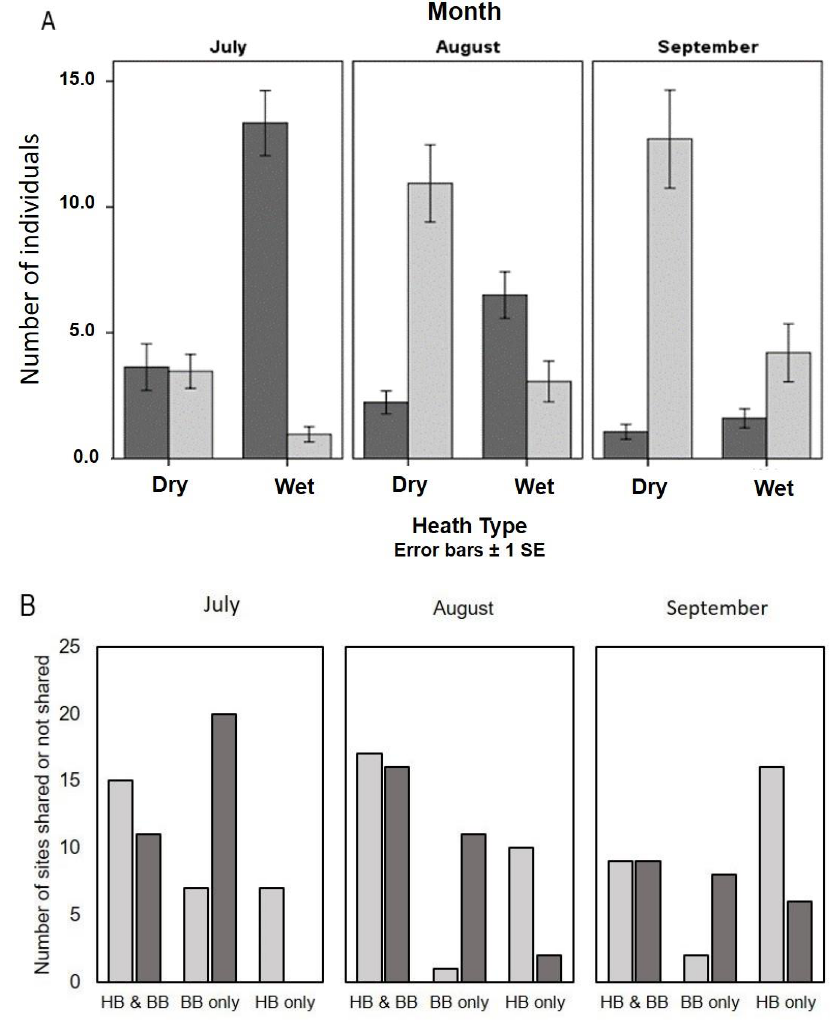
Figure 2. (A) The mean number of bumble bee (dark grey) and honey bee (light grey) observations on wet and dry heaths in July, August and September. Wet heath sites are dominated by E. tetralix and